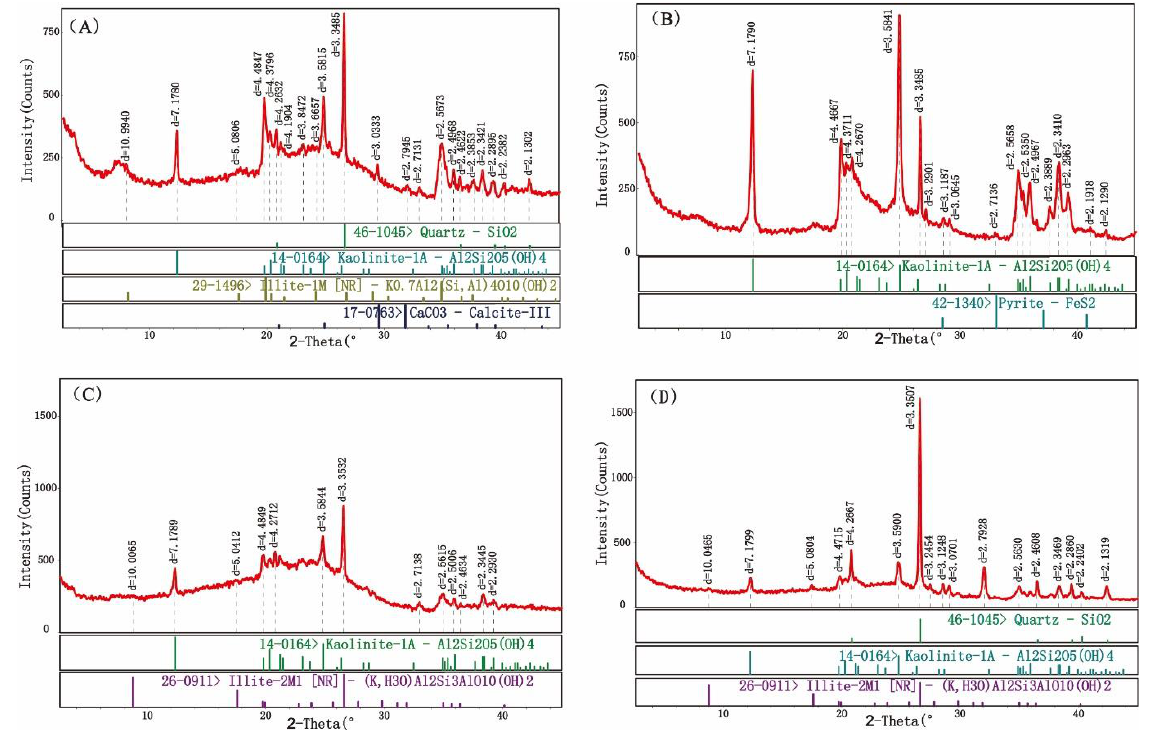
Figure 9. XRD patterns of No. 26 coals of Junde mine. ( A ) Sample JD-26-02; ( B ) sample JD-26-04; ( C ) sample JD-26-05; ( D ) sample JD-26-08. ( C ) sample JD-26-05; ( D ) sample JD-26-08.